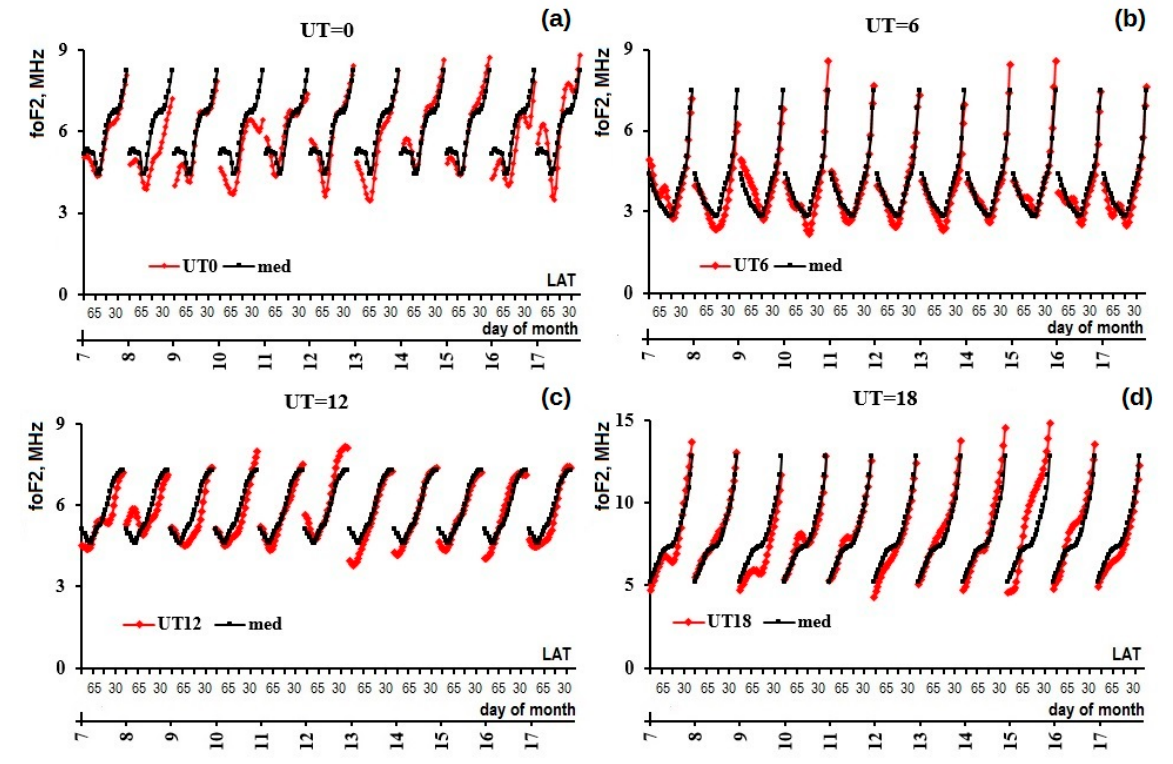
Atmosphere 2021 , 12 , x FOR PEER REVIEW Figure 10. The same as in Figure 5 but for latitudinal foF2(rec) dependences. Figure 10. The same as in Figure 5 but for latitudinal foF2(rec) dependences.